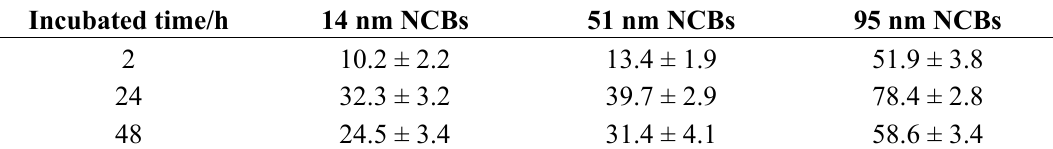
Table 1. Cellular uptake amounts of 99m Tc-NCBs (ng/1000 cell, mean ±